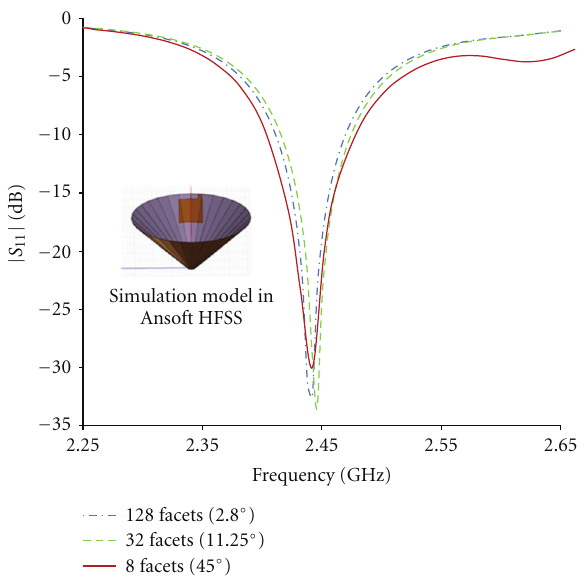
Figure 7: Simulation results showing | S 11 | of the antenna for 128, 32, and 8 facets of the cone representing 2.8 ◦ , 11.25 ◦ , and 45 ◦